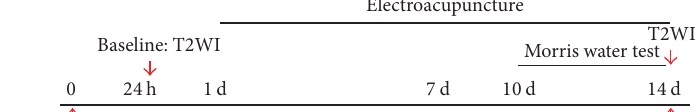
Figure 1: Experimental design used in the